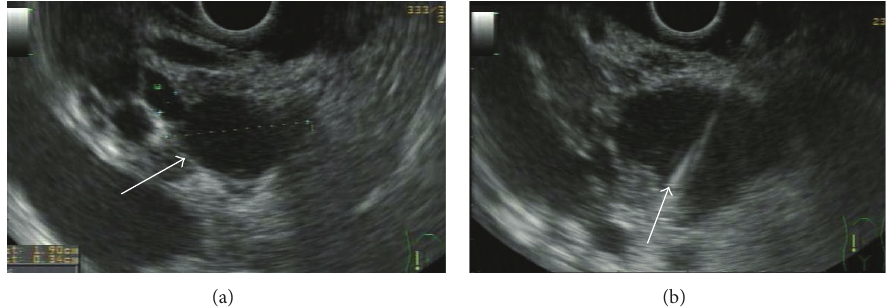
Figure 5: Linear EUS image of a MD-IPMN (a): a lobulated anechoic cystic lesion is clearly depicted (white arrow). (b) shows EUS-FNA of the same lesions. In this lesion (about 3 cm in size), the absence of mural nodules and positive or suspicious cytology allowed a conservative